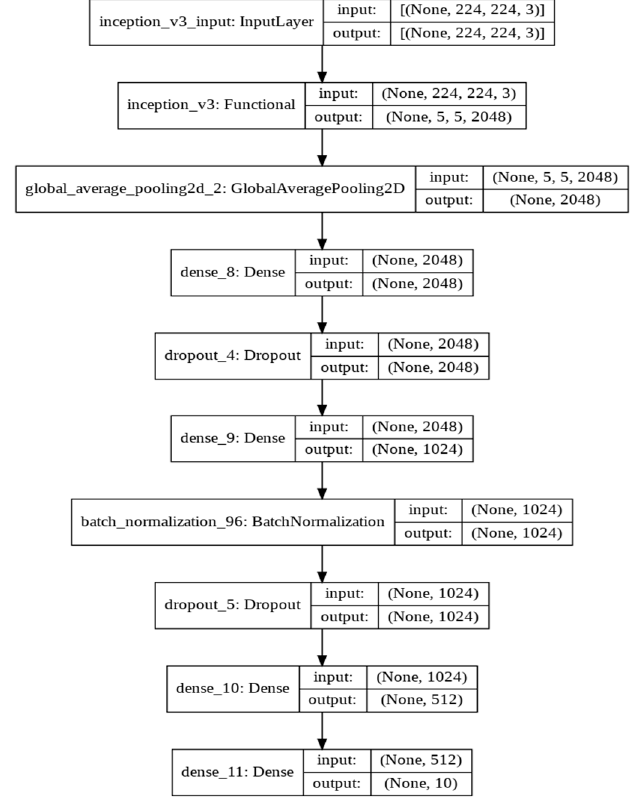
Figure 8. The Inception Model Architecture.